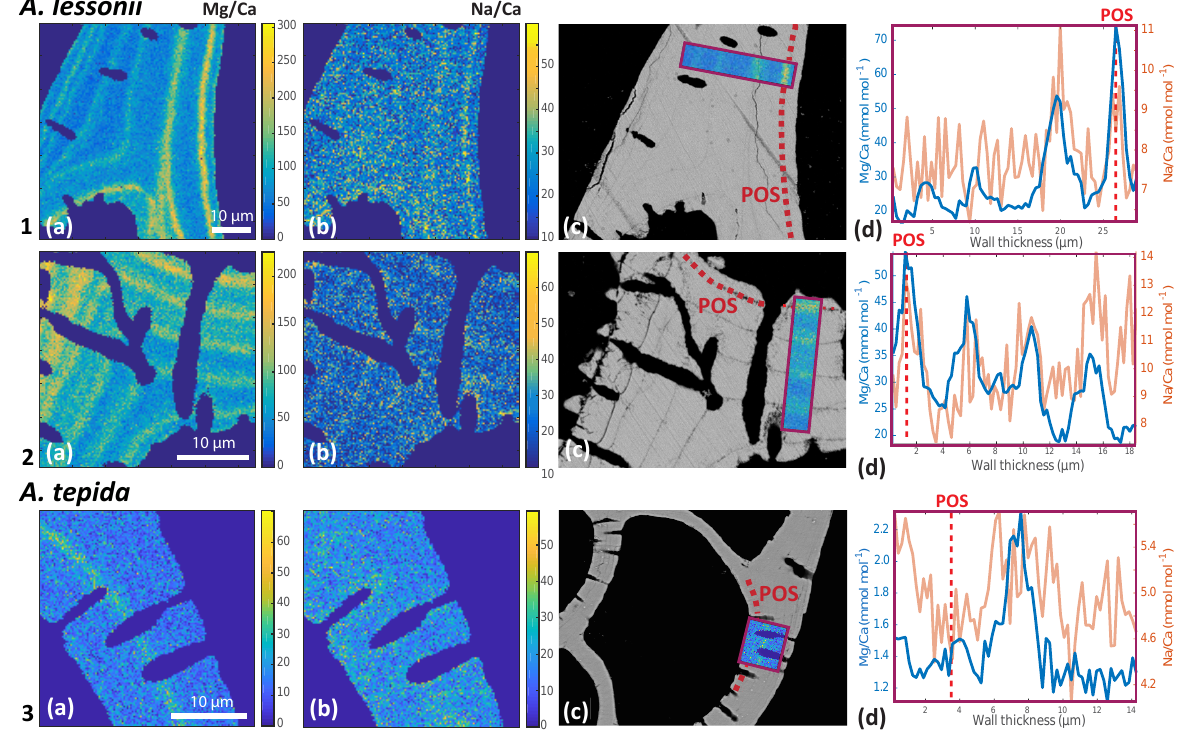
Figure 4. Foraminiferal Mg / Ca cc (panels a ) and Na / Ca cc (panels b ) intensity ratio maps, obtained with EPMA, for two specimens of A. lessonii grown at a salinity of 30 (row 1) and 25 (row 2) and one specimen of A. tepida (row 3). Panels (d) show profiles for Mg / Ca (blue) and Na / Ca (red), based on averaged EPMA ratios scaled to LA-ICP-MS measurements of the same specimen, of an averaged lateral profile area through the chamber wall perpendicular to the lamella separated by organic linings (purple rectangles in c ). The transect area is indicated with a purple rectangle, on top of a backscatter SEM image (c) , showing that the high El / Ca bands overlap with the primary organic sheet (POS, marked with dashed red line) and subsequent organic linings. See Supplement S4 for the results for three more